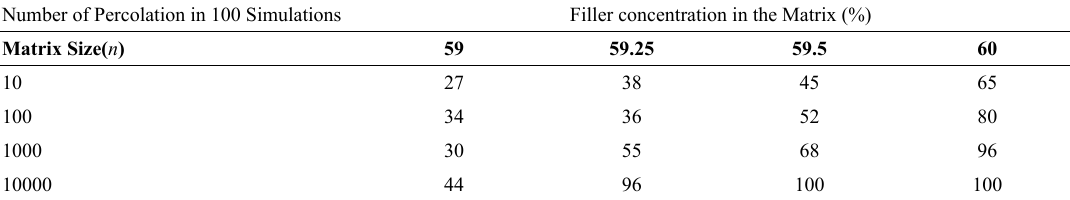
Table 2. Number of percolation in 100 simulations for different size